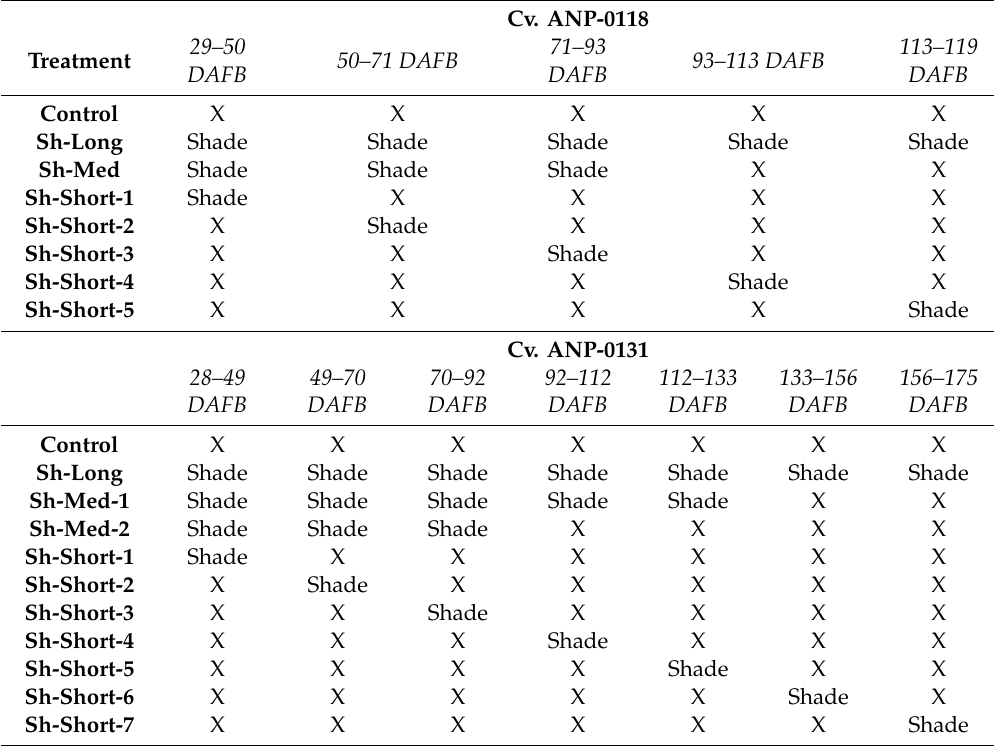
Table 3. Shading treatments of blush pear cvs. “ANP-0118” and “ANP-0131” applied over the 2018 / 2019 growing season. ‘X’ = no